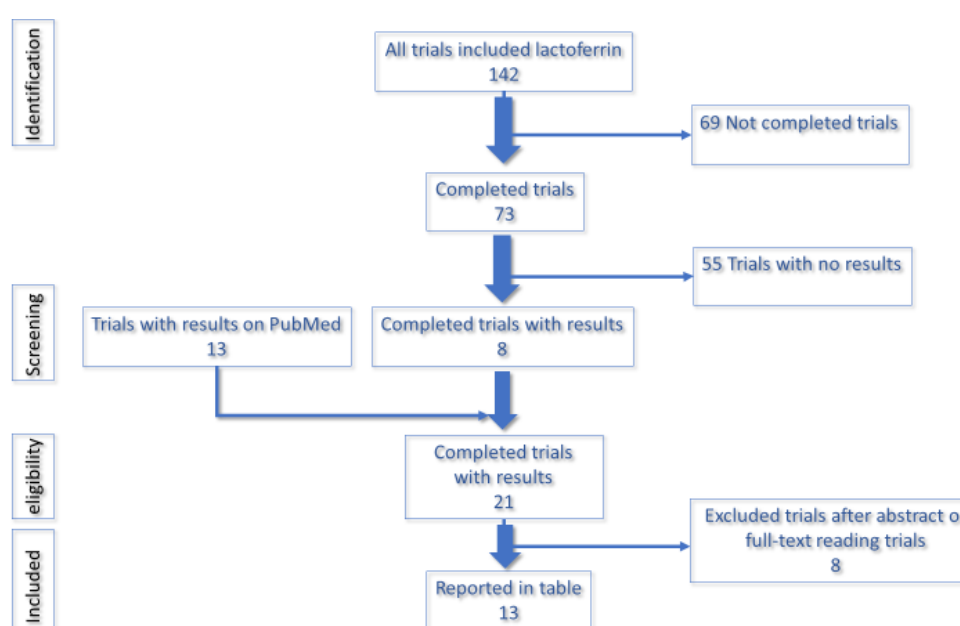
Figure 1. Flowchart summarizing the research strategy to select clinical trials of lactoferrin.